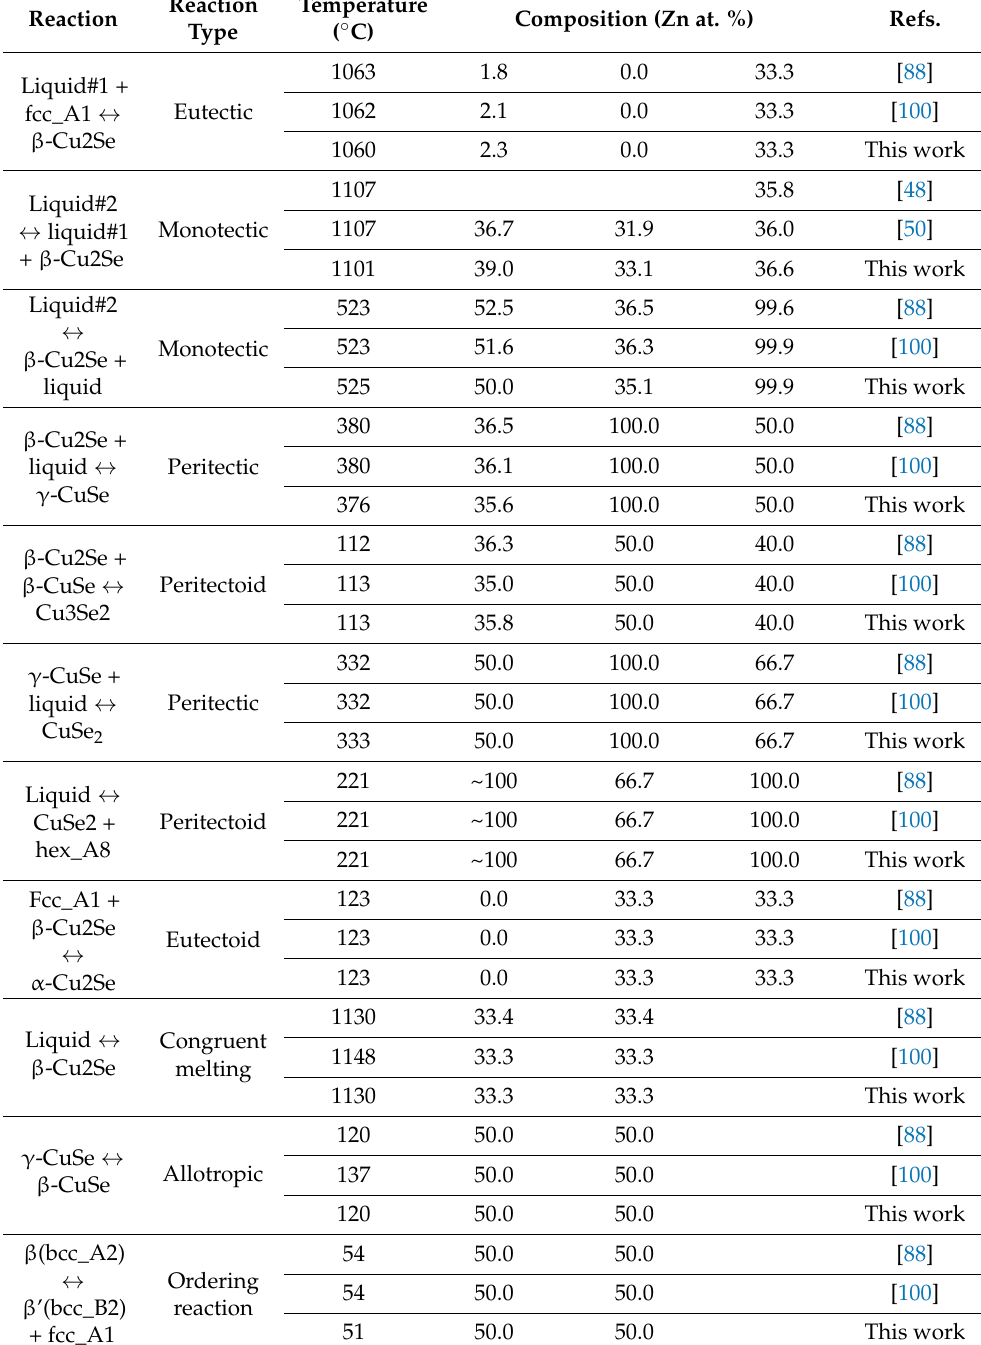
Table 8. The calculated invariant reactions in the Cu-Se system compared with the experimental data from ref. [88] and calculated data from ref.